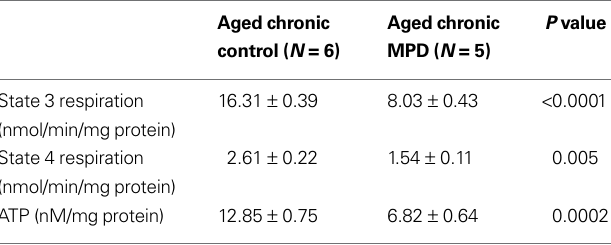
Table 4 | Mitochondrial respiration and ATP levels in the striatum of chronic aged (6–10 months old) MPD a